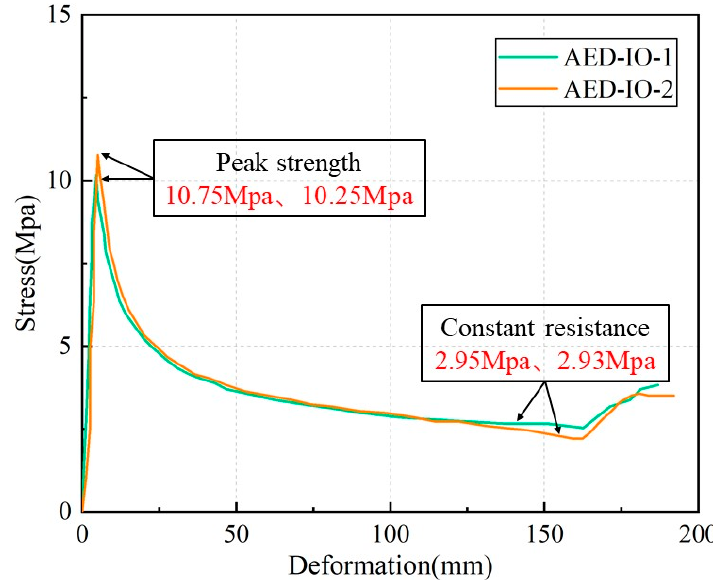
Figure 13. The stress–deformation curve of the AED-IOs.